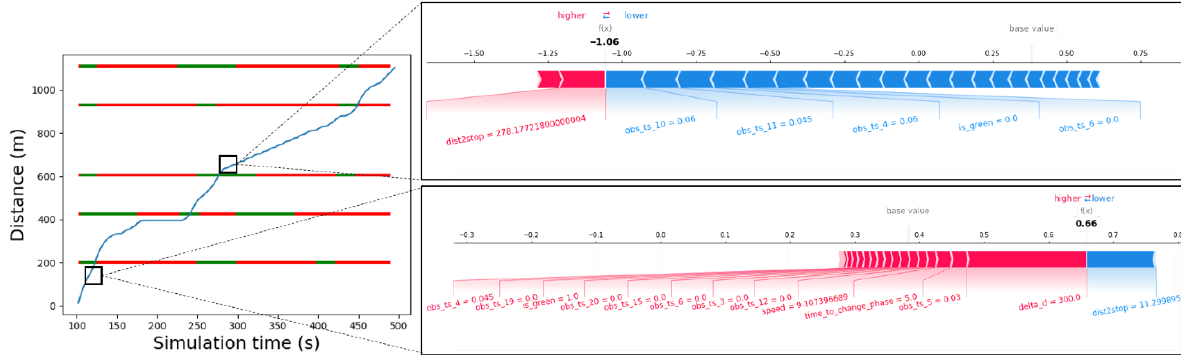
Figure 9. Energy consumption comparison for 20 groups of experiments.